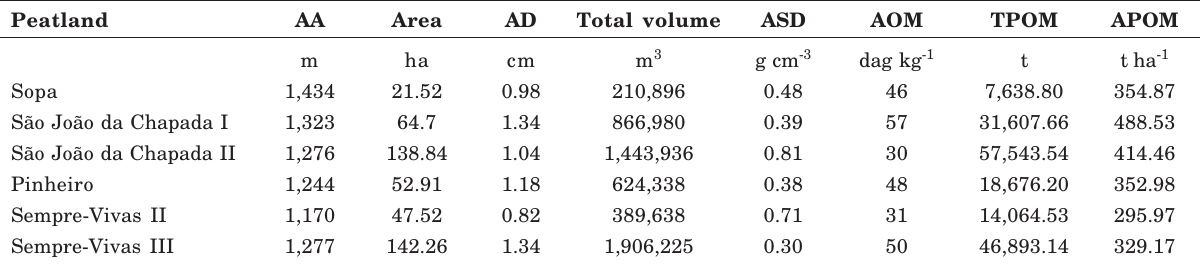
Table 3. Area, volume and organic matter stocks in six peatlands in the